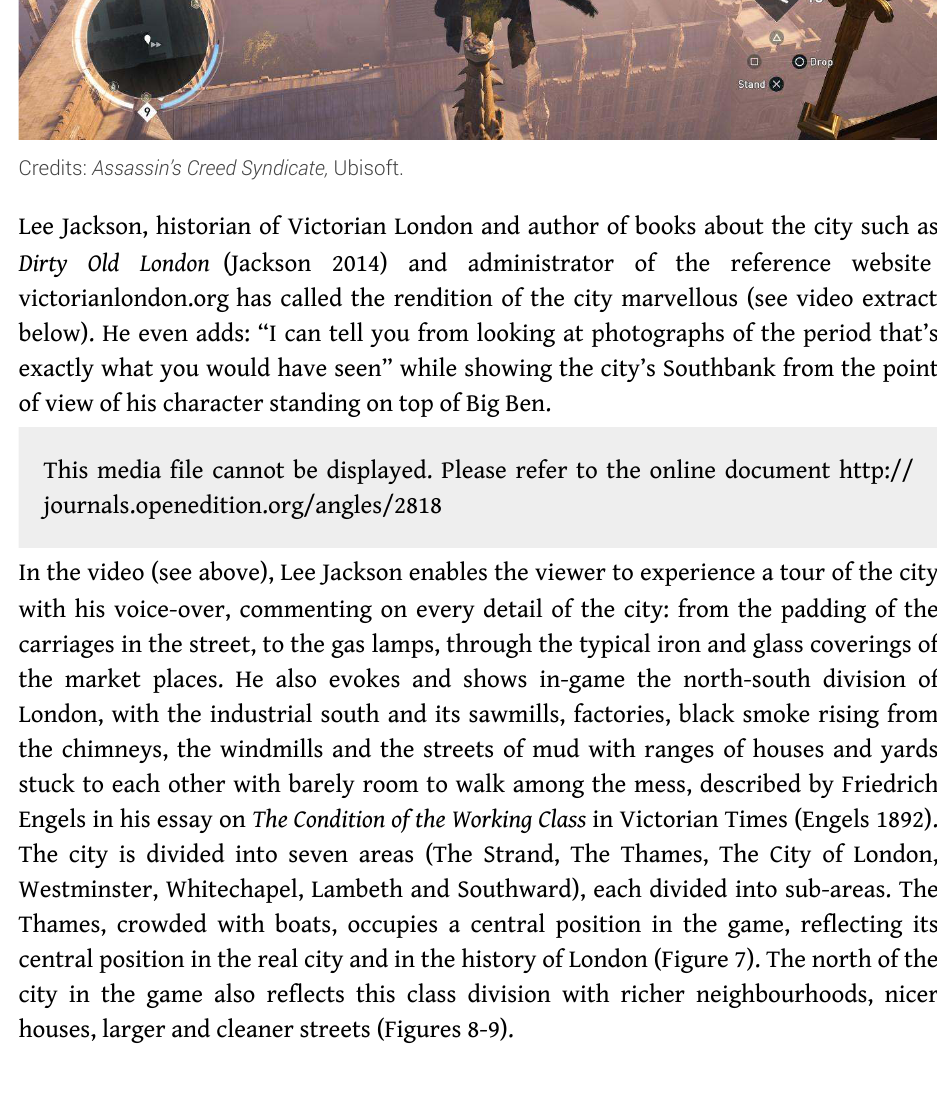
Credits: Assassin’s Creed Syndicate,